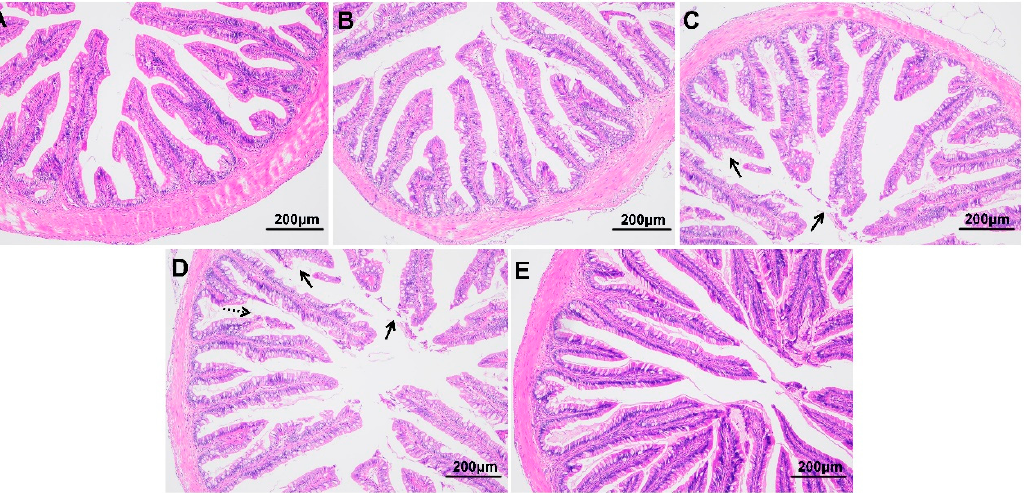
Figure 3. Intestinal morphology of largemouth bass under hypoxic stress for 0 h ( A ), 6 h ( B ), 24 h ( C ), 96 h ( D ) and 96 h of recovery under sufficient DO conditions ( E ) ( n = 12). Solid arrow: intestinal epithelial injury; dotted arrow: ruptured intestinal villus. Table 2. Morphological indices of largemouth bass under hypoxic stress followed by 96 h of recovery. Hyp_0 h